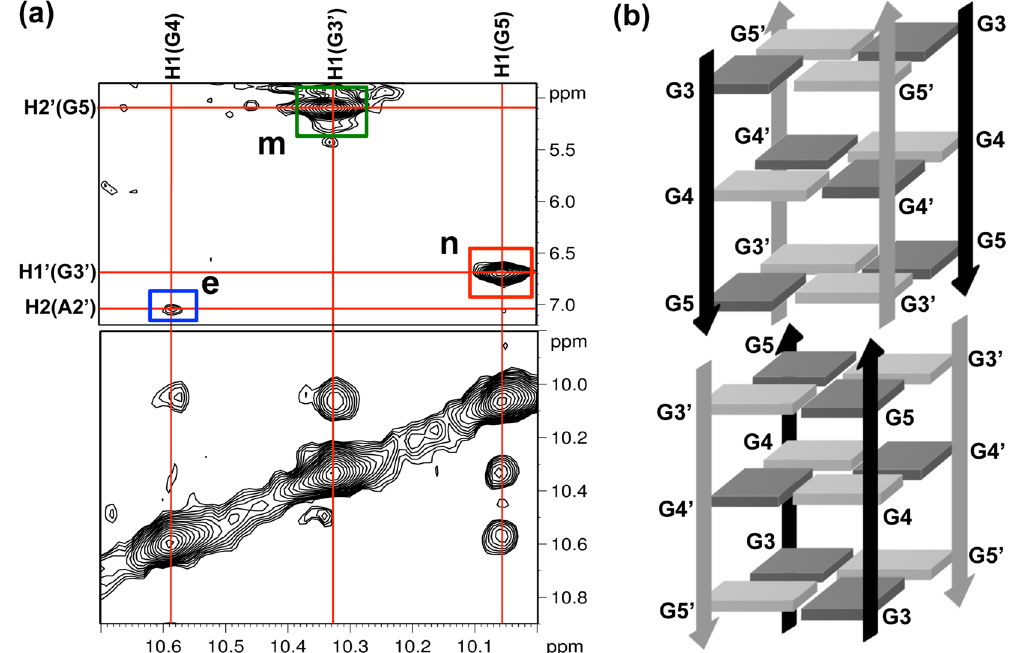
Figure 4. ( a ) NOE peaks of the ORN-2 indicating the stacking between two G-quadruplexes are framed and labeled: n, H1(G5)–H1 ′ (G3 ′ ); m, H1(G3 ′ )–H2 ′ (G5); e, H1(G4)–H2(A2 ′ ). ( b ) Schematic structure of dimer RNA G-quadruplex.